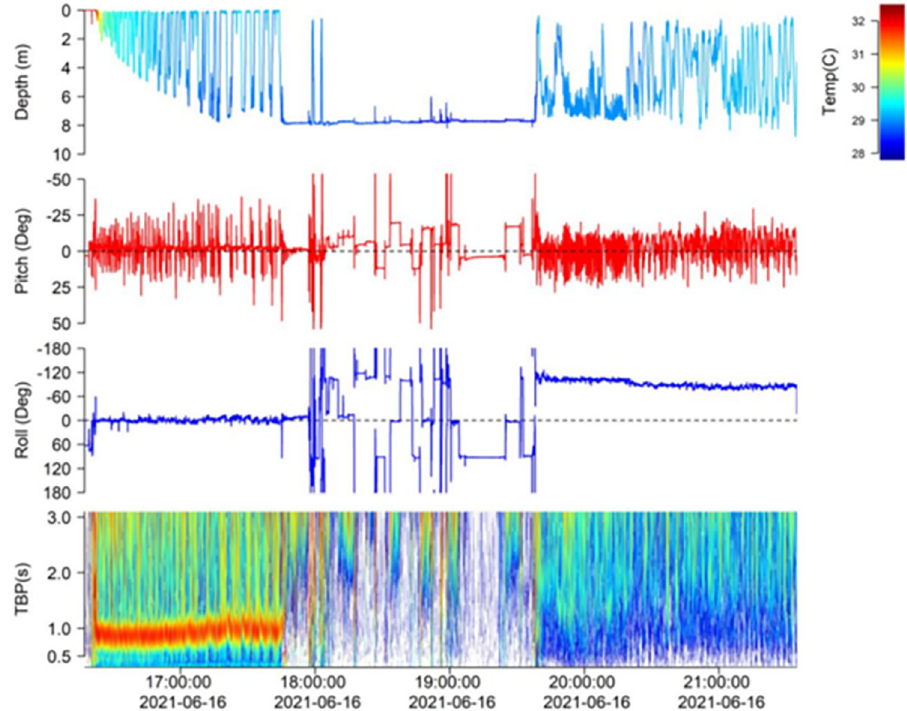
Fig 4. Example of ADL tag data from a blacktip shark (C_lim14). 1 hour after tagging, the shark descended to the seafloor, where it remained for 2 hours at constant depth, indicating mortality. In the first hour post release there are clear tail beats, some temperature stratification and the shark is level (Roll ~ 0). However, this shark then dies as evidence of a lack of tailbeats and laying on the seafloor. After ~10 mins on the seafloor it looks like the shark begins to get scavenged as the shark begins to roll into different positions. 1.5 hours after it initially rested on the seafloor the tag appears to be ingested by a predator. The tag is rolled 120 degrees in the predator’s stomach and because the tag is no longer aligned in the same way, we do not see a clear tailbeat signal in the frequency spectrum. Additionally, as this predator swims up and down in the water column we see no temperature stratification. This tag stayed in the predator’s stomach for ~50 Hours before being